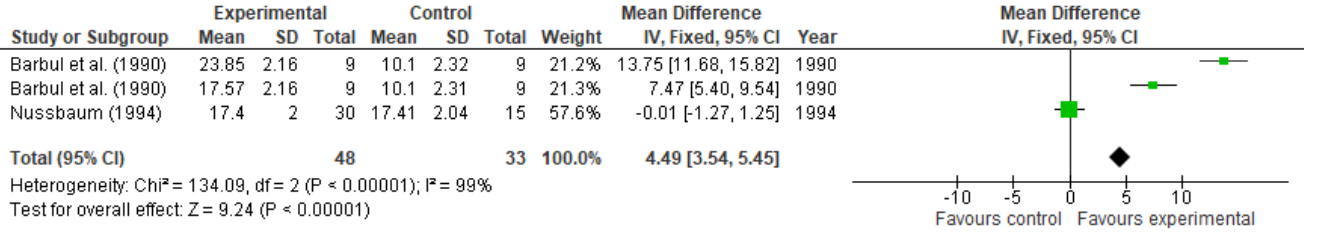
Figure 8. Hydroxyproline content: fixed-effects meta-analysis and forest plot from studies providing supplementation of arginine.